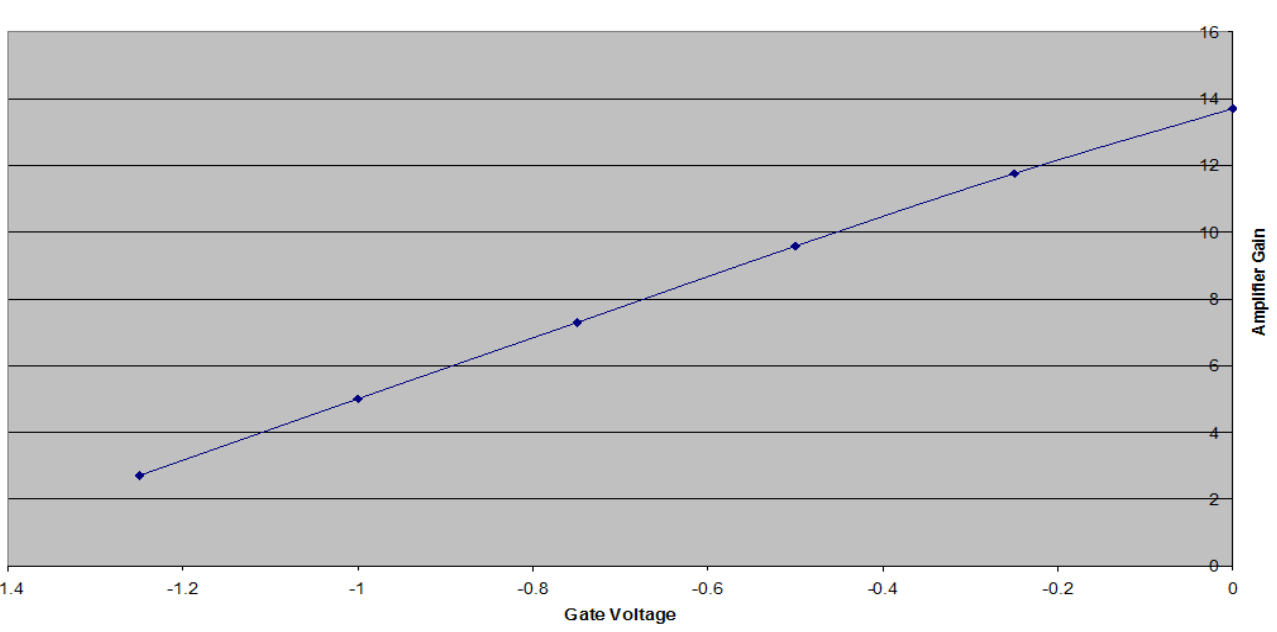
Fig. 5: The effect of gate voltage on amplifier